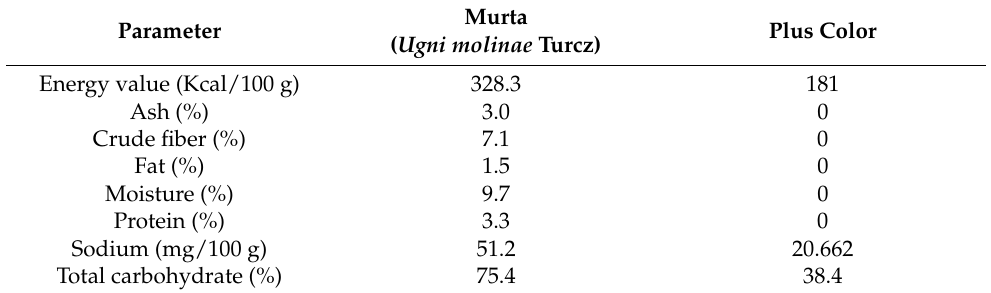
Table 1. Chemical composition of antioxidants ingredients used in frankfurters formulation.